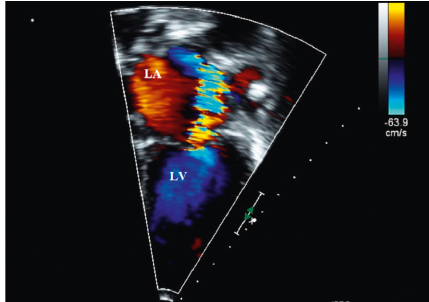
Figure 2: Transthoracic echocardiogram in apical four-chamber view demonstrating enlargement of the left atrium (LA) and severe mitral valve